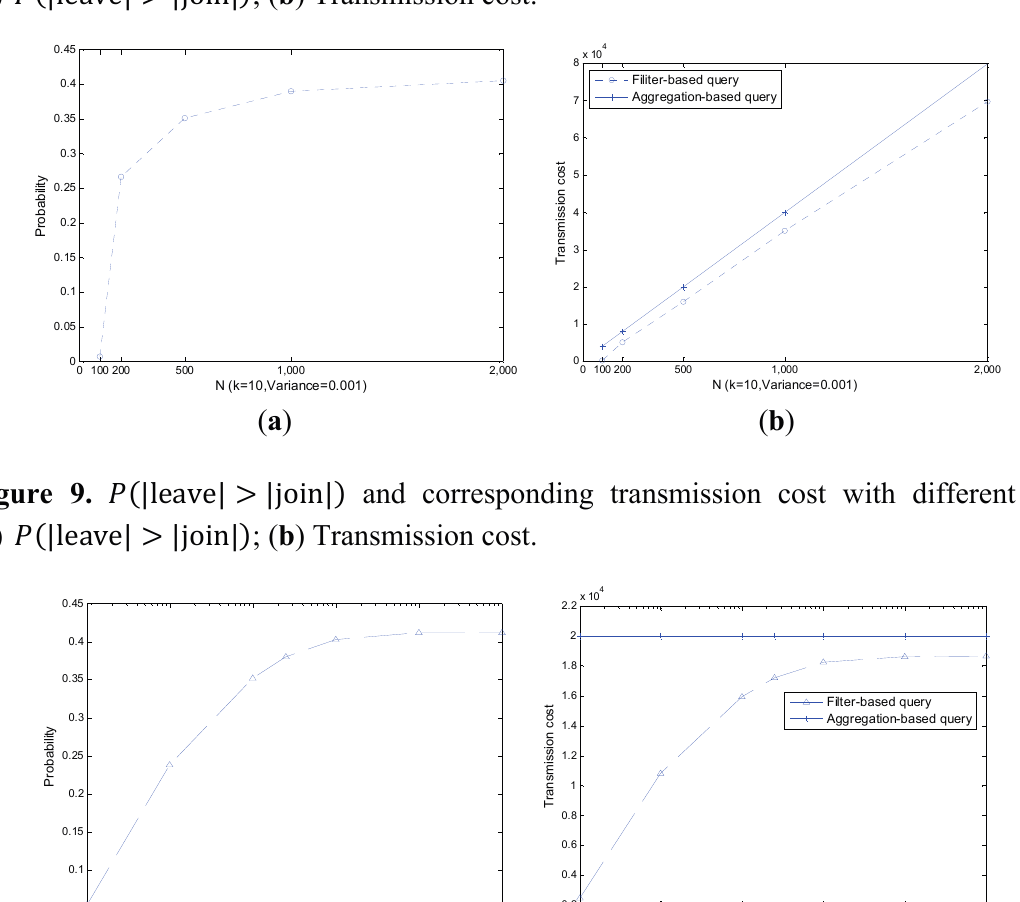
Figure 8. (cid:1842)(|leave| > |join|) and co.rresponding transmission cost with different (cid:1863) . ( a ) (cid:1842)(|leave| > |join|) ; ( b ) Transmission cost.